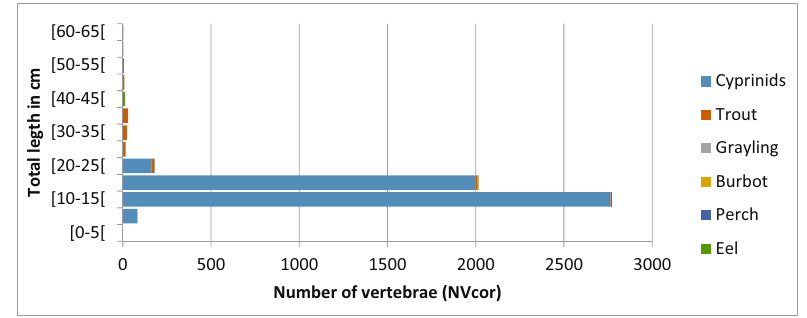
Figure 8: Projected size distribution of reconstructed fi sh sizes, all taxa, from layer 3, N = 5,158 ( size distribution patterns observed for each species have been applied to total corrected number of vertebrae from the species ) .